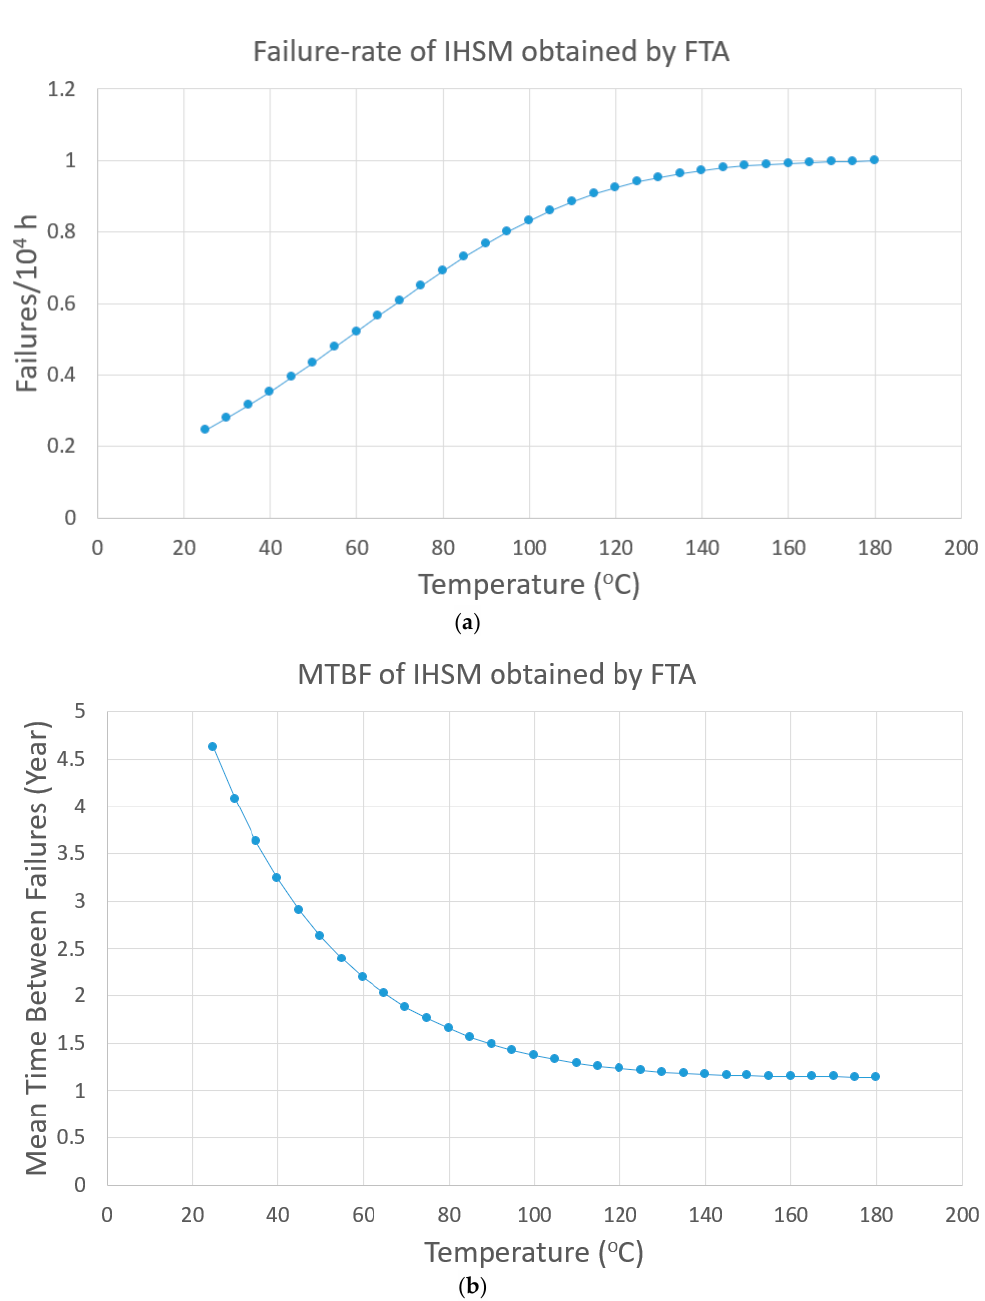
Figure 18. Failure rate and MTBF (mean time between failures) of IHSM, ( a ) failure rate, ( b ) MTBF, year.